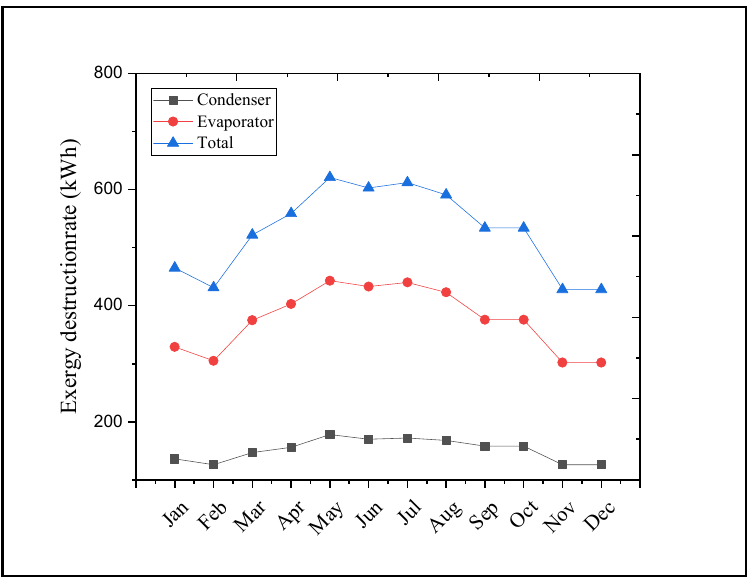
Figure 11. Total exergy, evaporator exergy and condenser exergy for the months of the